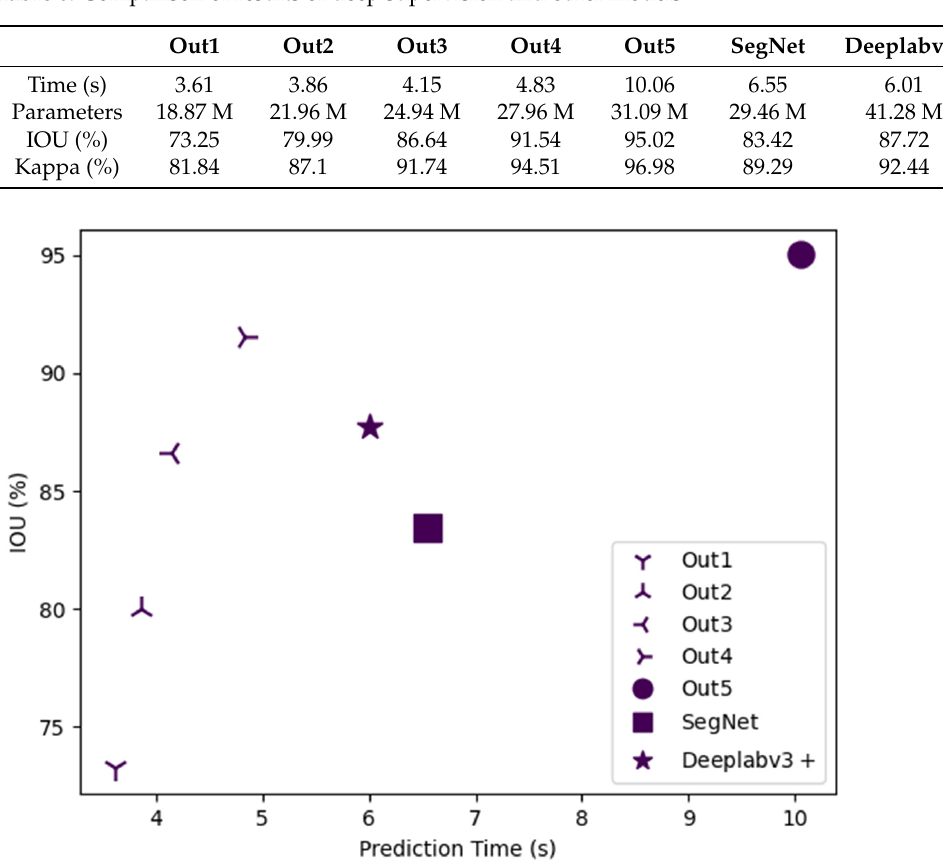
Figure 13. Prediction time and IOU of deep supervision and other models .